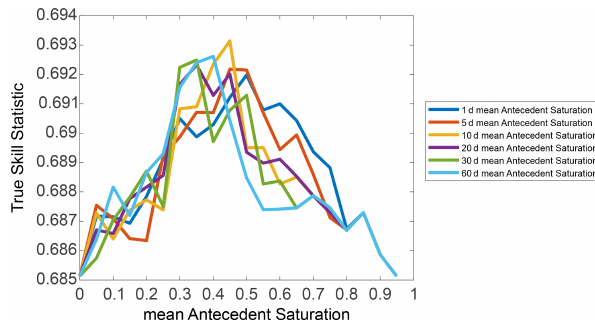
Figure 8. True skill statistic values associated with the dual total rainfall–duration (ED) thresholds for high/low antecedent satura- tion conditions separated by thresholds of mean antecedent satura- tion ( x axis). Colour lines represent different N d antecedent condi- tion time